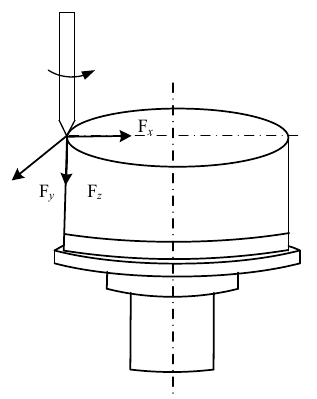
Figure 2. Decomposition of milling force.